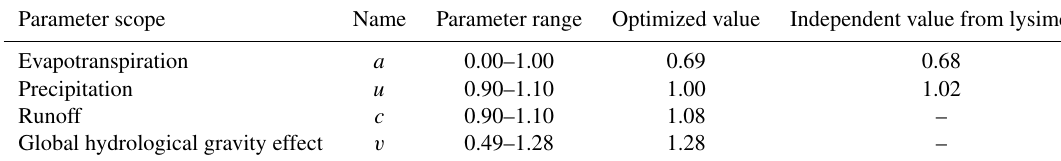
Table 2. Parameters of the water balance equation adjusted during optimization (see text for detailed explanations).